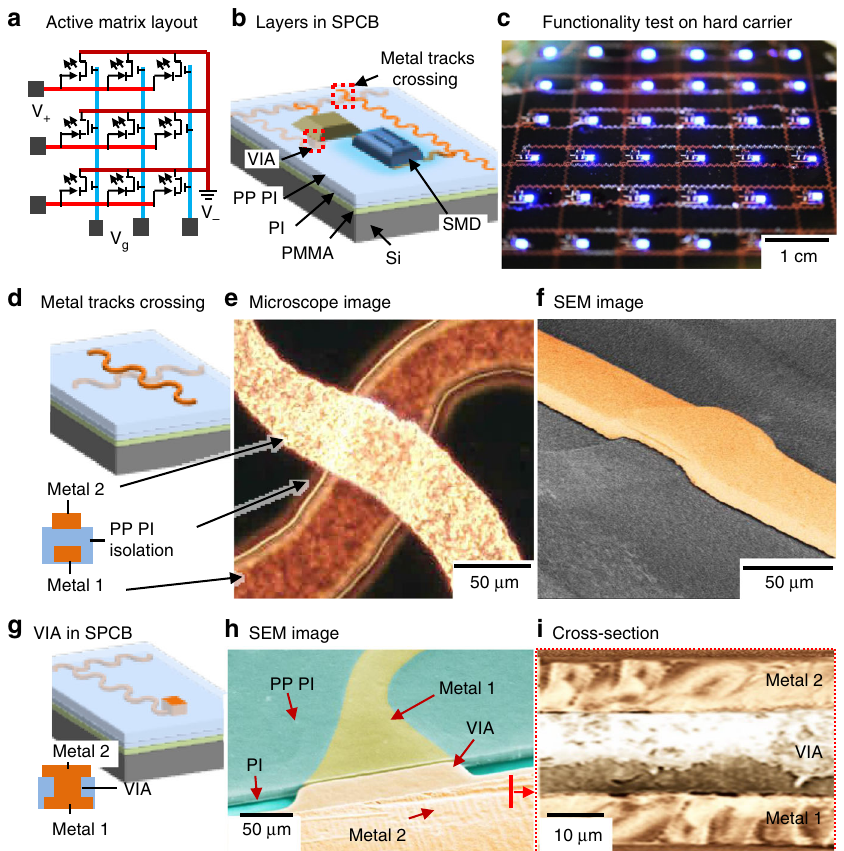
Fig. 1 First steps to realize integrated stretchable printed circuit boards. Schematic layout of an active matrix using LEDs and transistors ( a ), layers build-up in the SPCB ( b ) and “ on-hard-carrier ” functionality test ( c ). Metal layers crossing: schematics ( d ) next to corresponding optical microscope image ( e ), and colored SEM image ( f ); the two metal layers are separated by a 20 µ m thick photo-patternable PI layer, the layer is black in the microscope and gray in the SEM image. VIA: schematics ( g ) next to a colored tilted SEM image ( h ) depicting the PI peeling layer (turquoise), bottom metal (yellow) (in parts covered by photo-patternable PI, (darker turquoise), VIA (reddish), and top metal (reddish) and cross-section ( i ) of the same. PI polyimide, PMMA poly(methyl- methacrylate), PP PI photo-patternable PI, SMD surface mount device, VIA vertical interconnect access, SPCB stretchable printed circuit